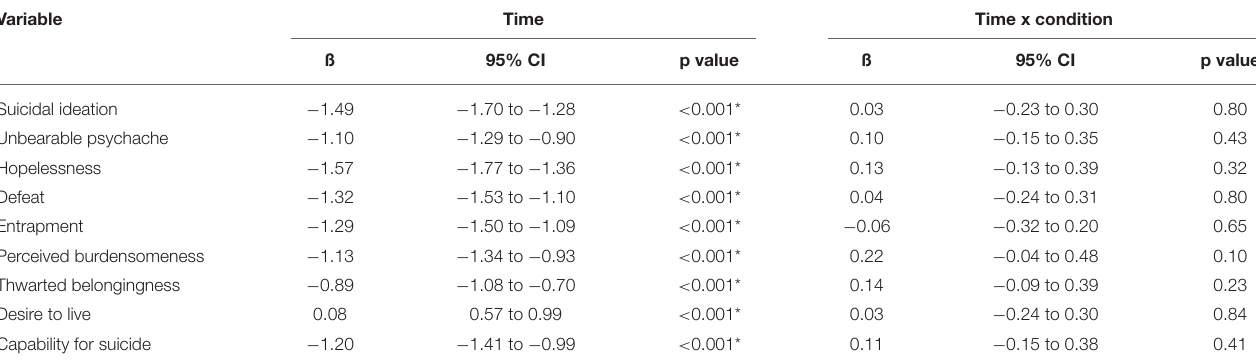
TABLE 4 | Mixed-model estimates for all suicide risk factors in the full models.